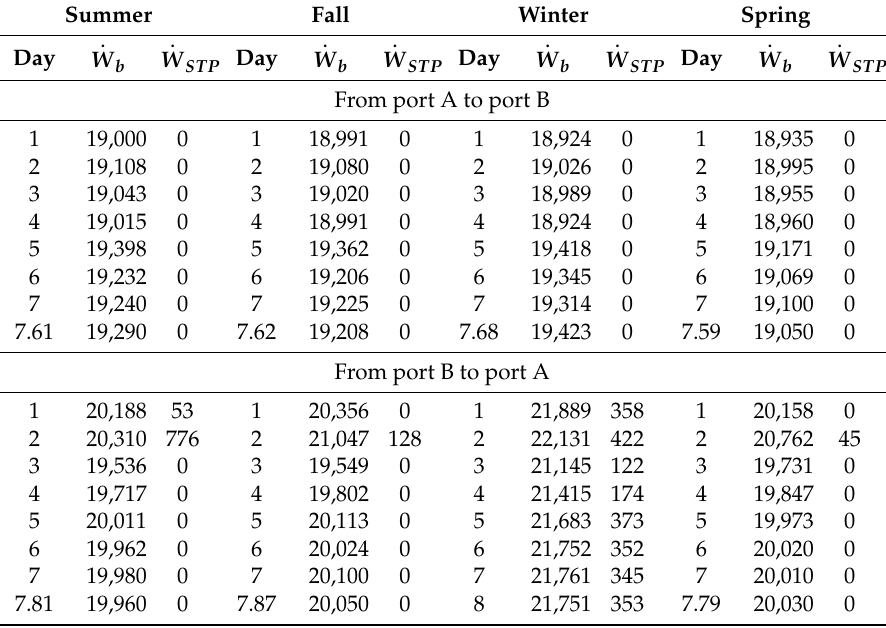
Table 31. Propulsion power from Diesel engine(s) and ST versus time (in kW).